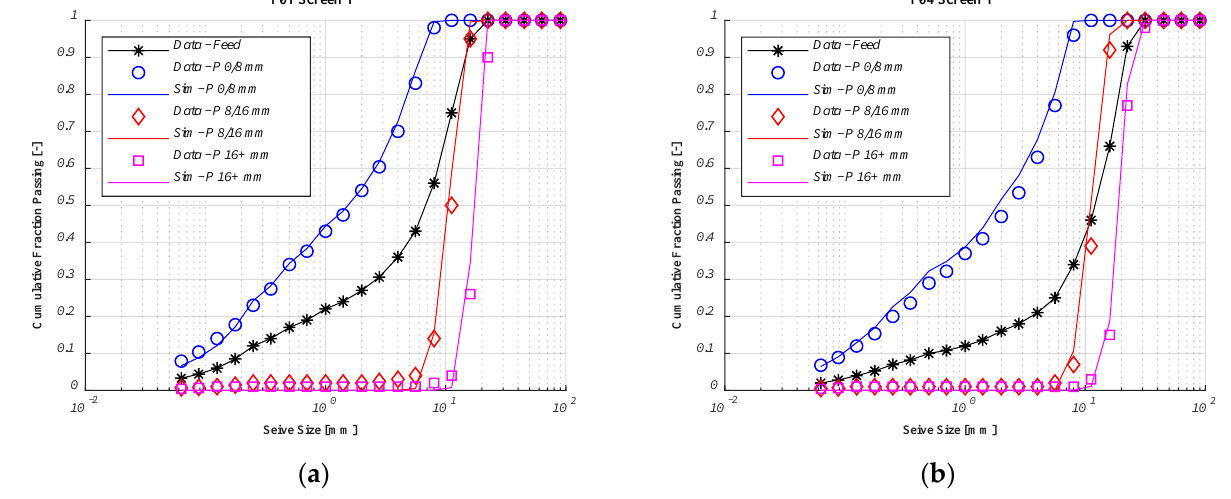
Figure 12. Screen 1 calibration results for ( a ) T01 and ( b ) T04 in the cumulative domain.